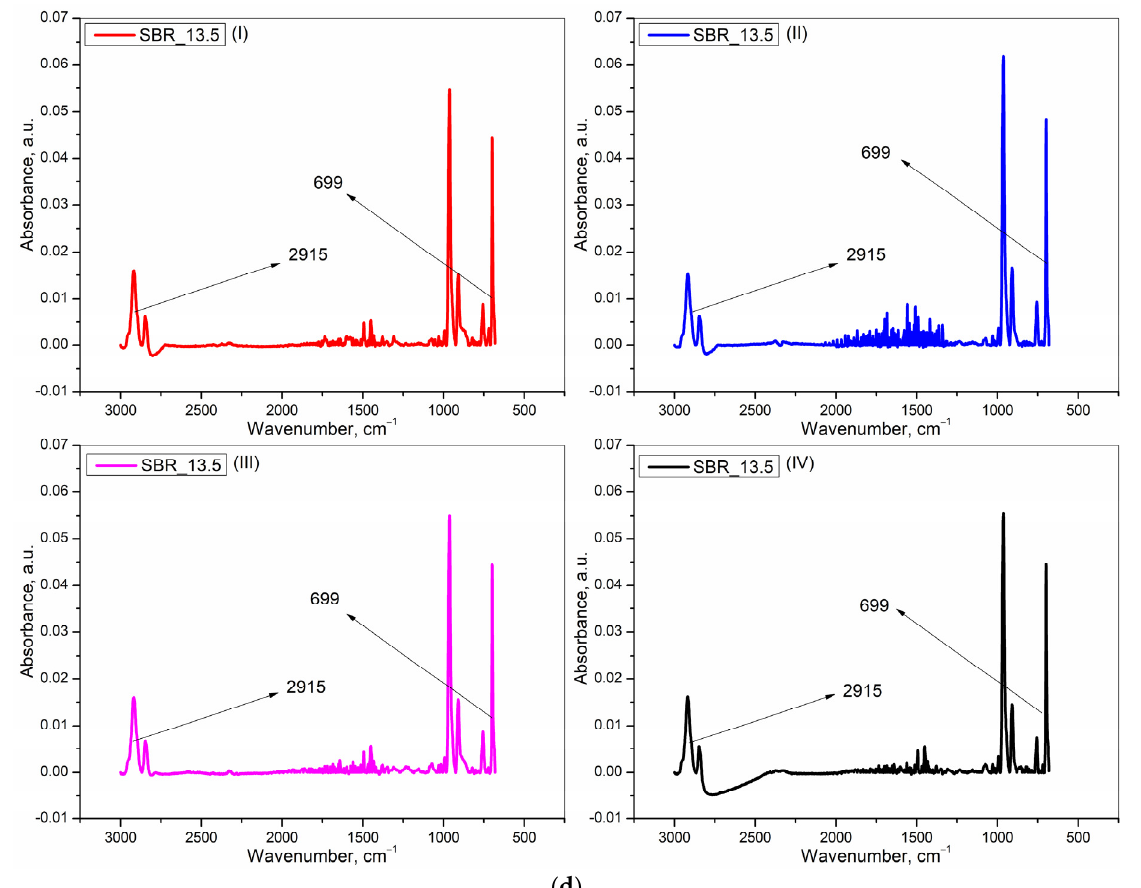
Figure 4. ( a ) Baseline subtracted IR spectra for the compound at 0.0 phr of the initial oil concentration, with absorbance peaks for SBR at 699 cm − 1 and for a component other than oil at 2915 cm − 1 for (I) 10, (II) 100, and (III) 500 mm · min − 1 (tensile ruptured) and for (IV) cryo-ruptured samples. ( b ) Baseline subtracted IR spectra for the compound at 4.5 phr of the initial oil concentration, with absorbance peaks for SBR at 699 cm − 1 and (a component other than oil + the redistributed oil) at 2915 cm − 1 for (I) 10, (II) 100, and (III) 500 mm · min − 1 (tensile ruptured) and for (IV) cryo-ruptured samples. ( c ) Baseline subtracted IR spectra for the compound at 9.0 phr of initial oil concentration, with absorbance peaks for SBR at 699 cm − 1 and (a component other than oil + the redistributed oil) at 2915 cm − 1 for (I) 10, (II) 100, and (III) 500 mm · min − 1 (tensile ruptured) and for (IV) cryo-ruptured samples. ( d ) Baseline subtracted IR spectra for the compound at 13.5 phr of initial oil concentration, with absorbance peaks after baseline fitting and subsequent subtraction for SBR at 699 cm − 1 and (a component other than oil + the redistributed oil) at 2915 cm − 1 for (I) 10, (II) 100, and (III) 500 mm · min − 1 (tensile ruptured) and for (IV) cryo-ruptured